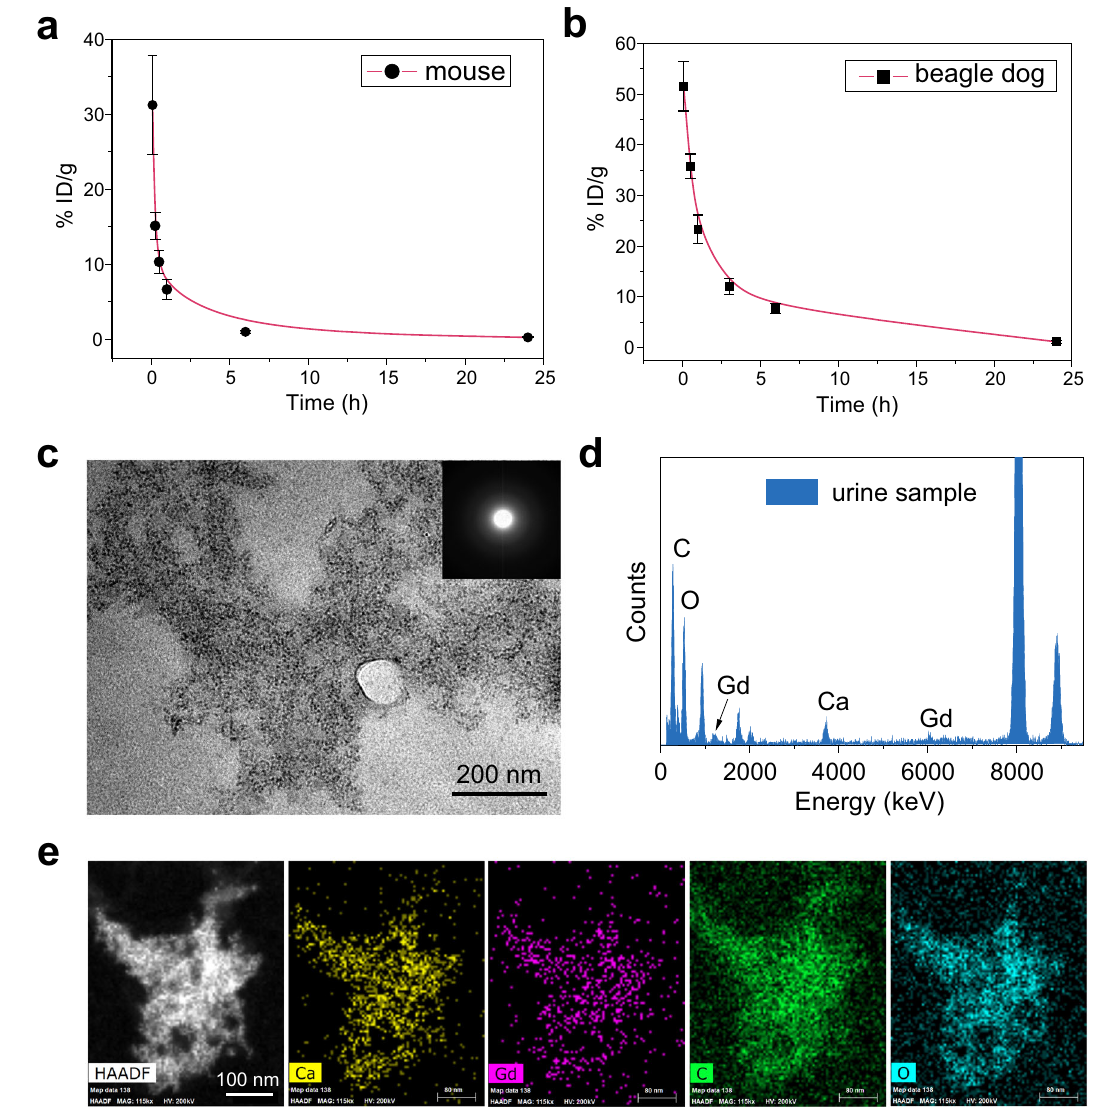
Fig. 6 | Metabolism of ACNC. a , b The time-dependent distribution of ACNC in plasma of a mice and b beagle dogs within 24h ( n =5 biologically independent animals). The data show means±SD. c TEM, d EDS results, and e HAADF-STEM